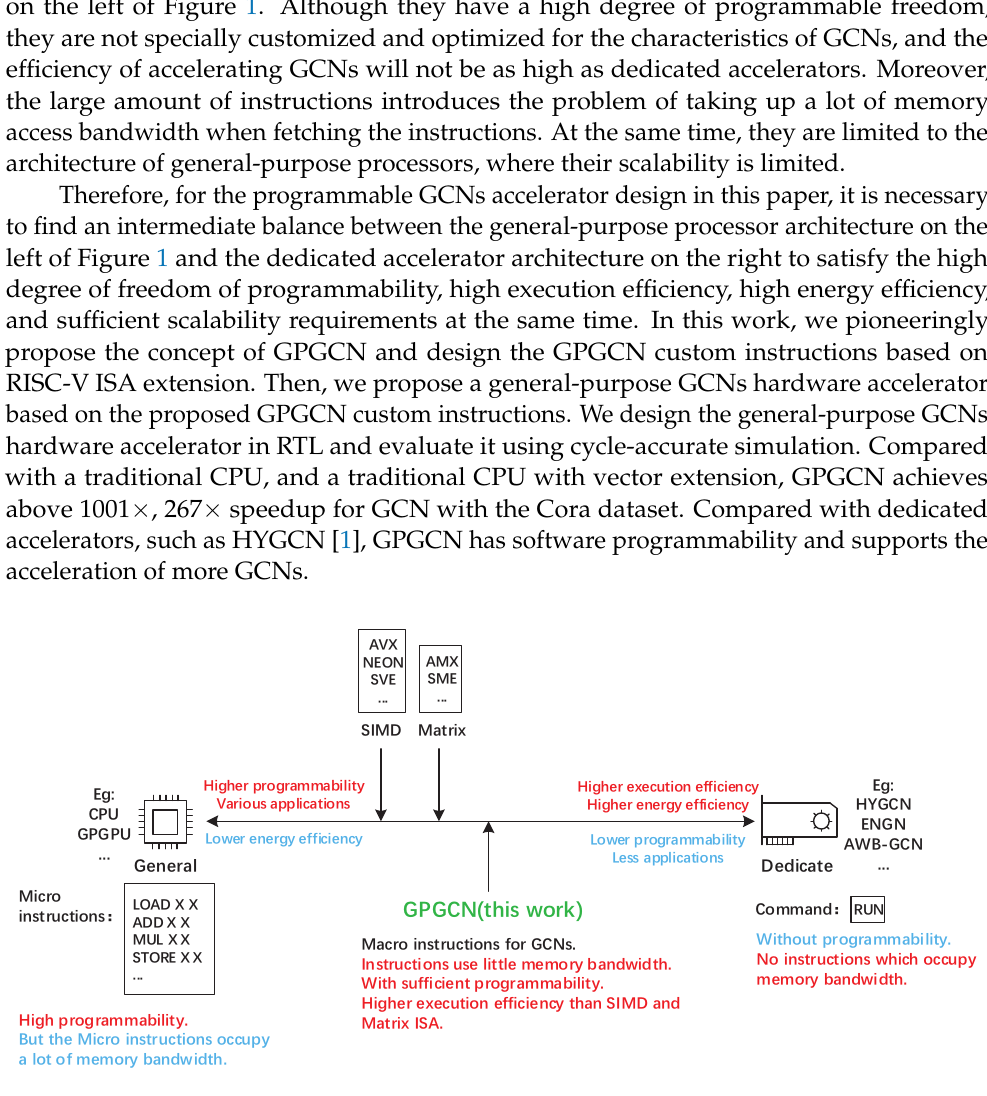
Figure 1. Differences between general-purpose processors, GPGCNs, and dedicated accelerators. Advantages are marked in red, while disadvantages are marked in